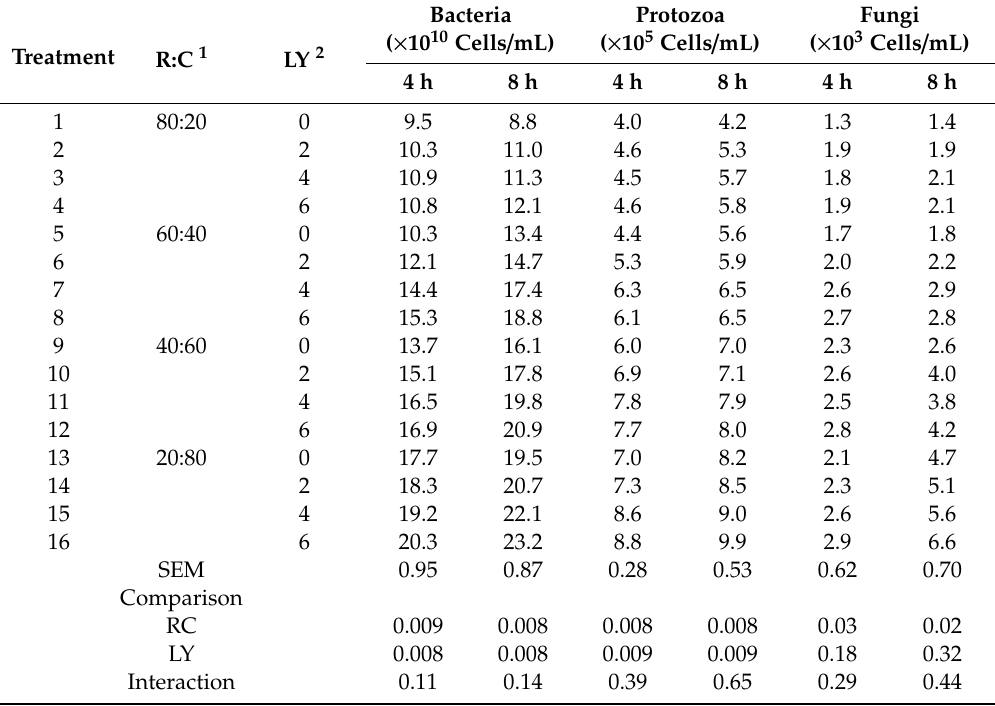
Table 5. The e ff ect of roughage-to-concentrate (R:C) ratio with live yeast (LY) supplementation on microbial